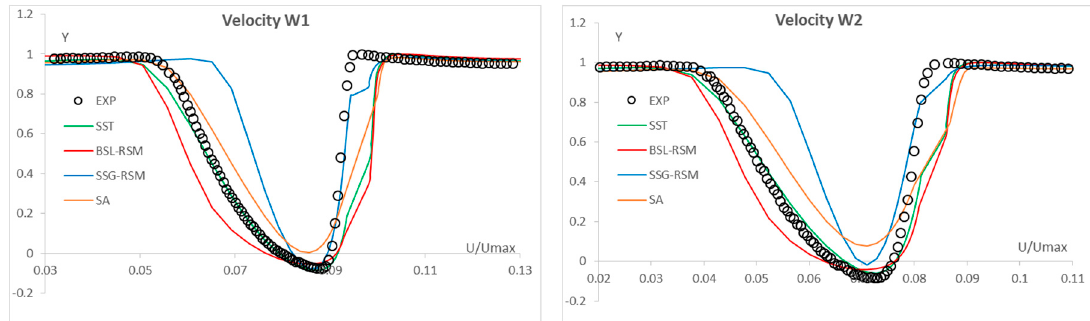
Figure 9. Velocity distributions on the DCA wake (averaged for the SSG-RSM).